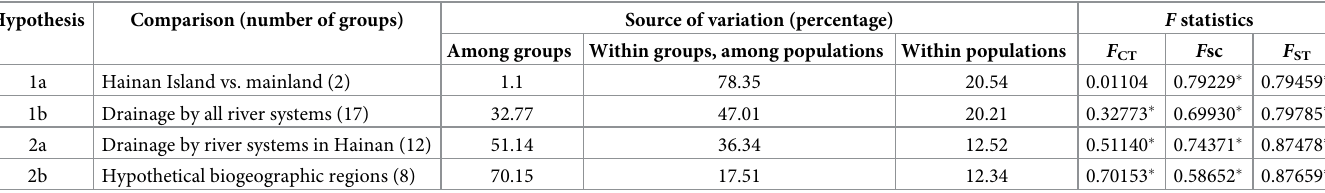
Table 4. Results from the analysis of molecular variance (AMOVA) used to evaluate two a priori biogeographical hypotheses. Hypothesis Comparison (number of